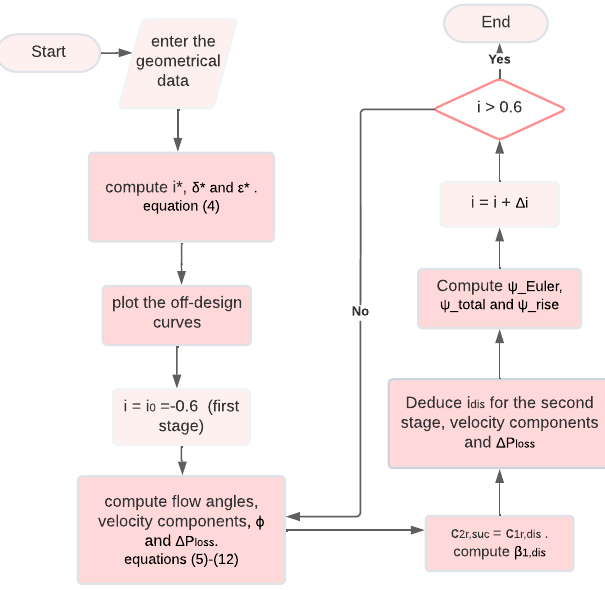
Figure 13. Cascade theory procedure applied in CFFs.